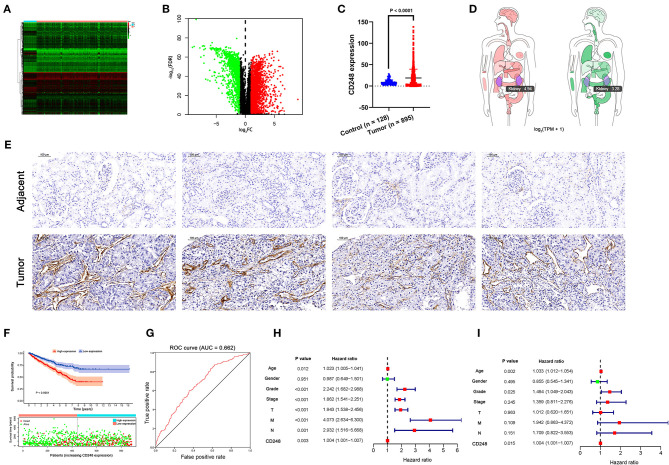
The expression and the prognostic value of CD248. (A) A heat map of DEGs. Green to red spectrum indicates low to high gene expression. (B) A volcano plot of DEGs. Red, green, and black dots represent upregulated, downregulated, and unchanged genes, respectively. (C) The overexpression of CD248 in tissues with RCC (D) A body map of the expression of CD248 (E) Immunohistochemical qualitative evaluation of CD248 in RCC. Scale bar = 100 μm. (F) The prognostic value of CD248. Ninety-five percent confidence interval is shown as light-colored background. (G) The ROC curve of CD248 (H) Univariate Cox regression analysis of CD248 (I) Multivariate Cox regression analysis of CD248. Red and green dots represent variables with hazard ratio > 1 and ≤ 1, respectively. p < 0.05 was considered statistically significant.